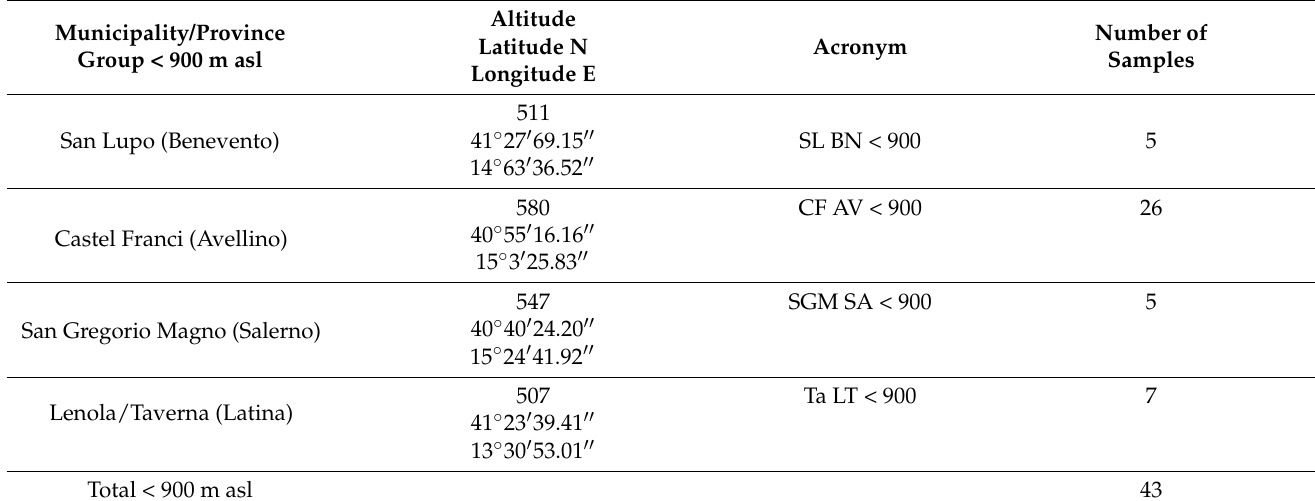
Table 1. Sampling sites located below 900 m asl: sampling municipality/province, altitude, geo- graphical coordinates, and acronyms used in the study are reported.